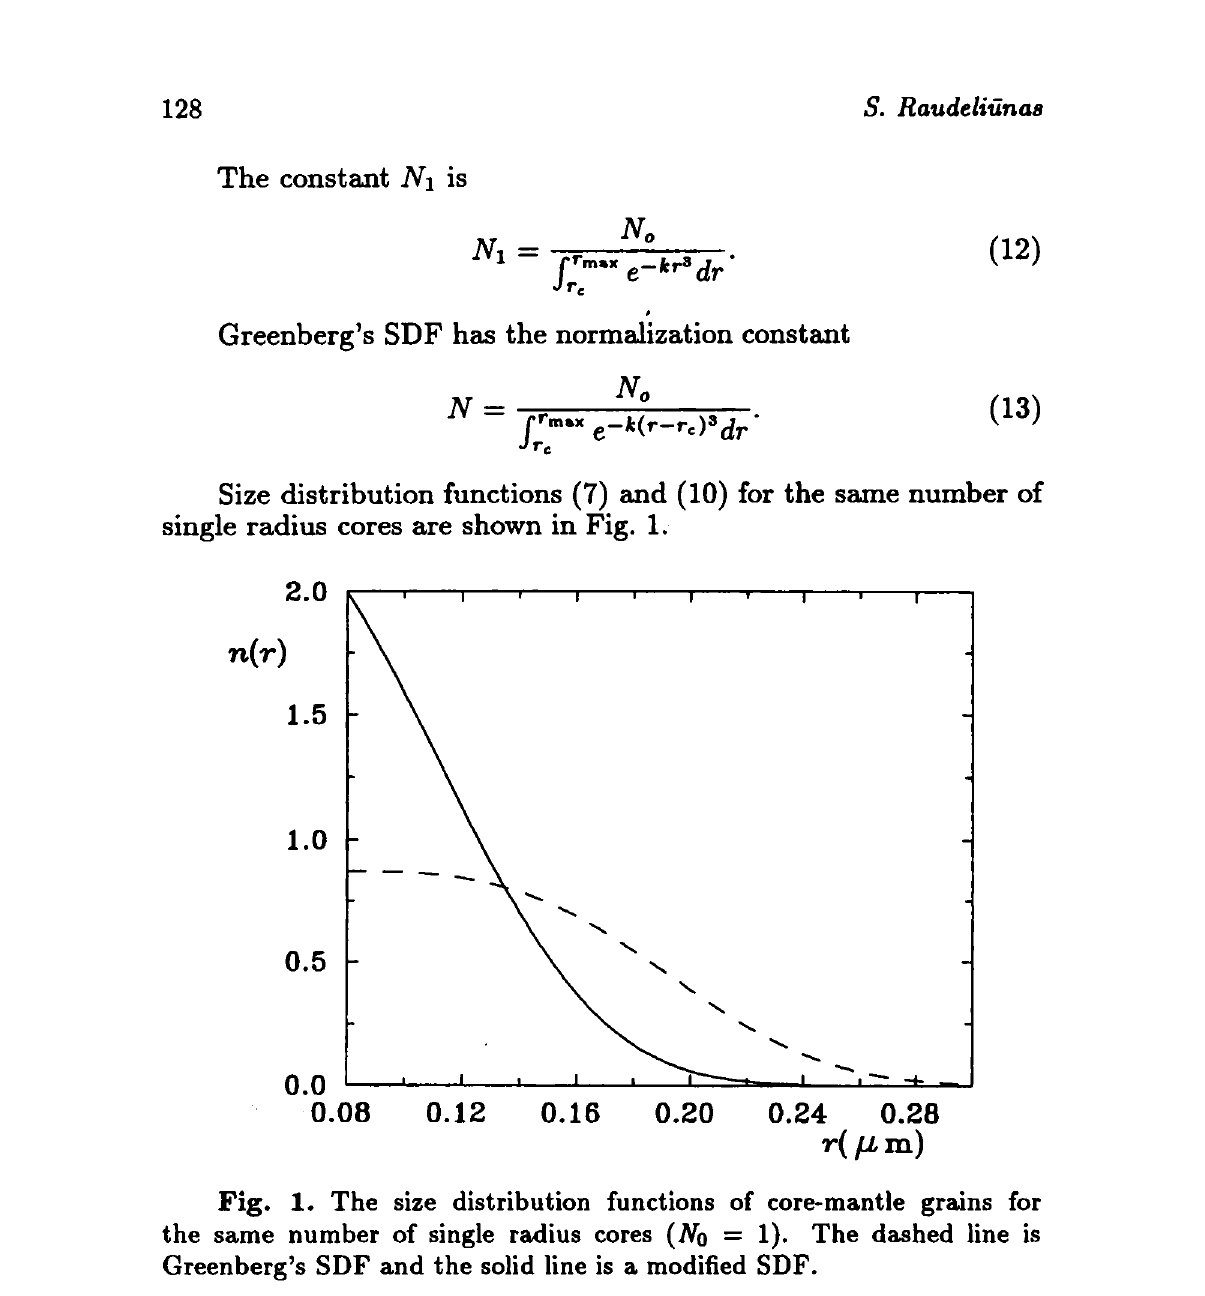
Fig. 1. The size distribution functions of core-mantle grains for the same number of single radius cores (No = 1). The dashed line is Greenberg's SDF and the solid line is a modified